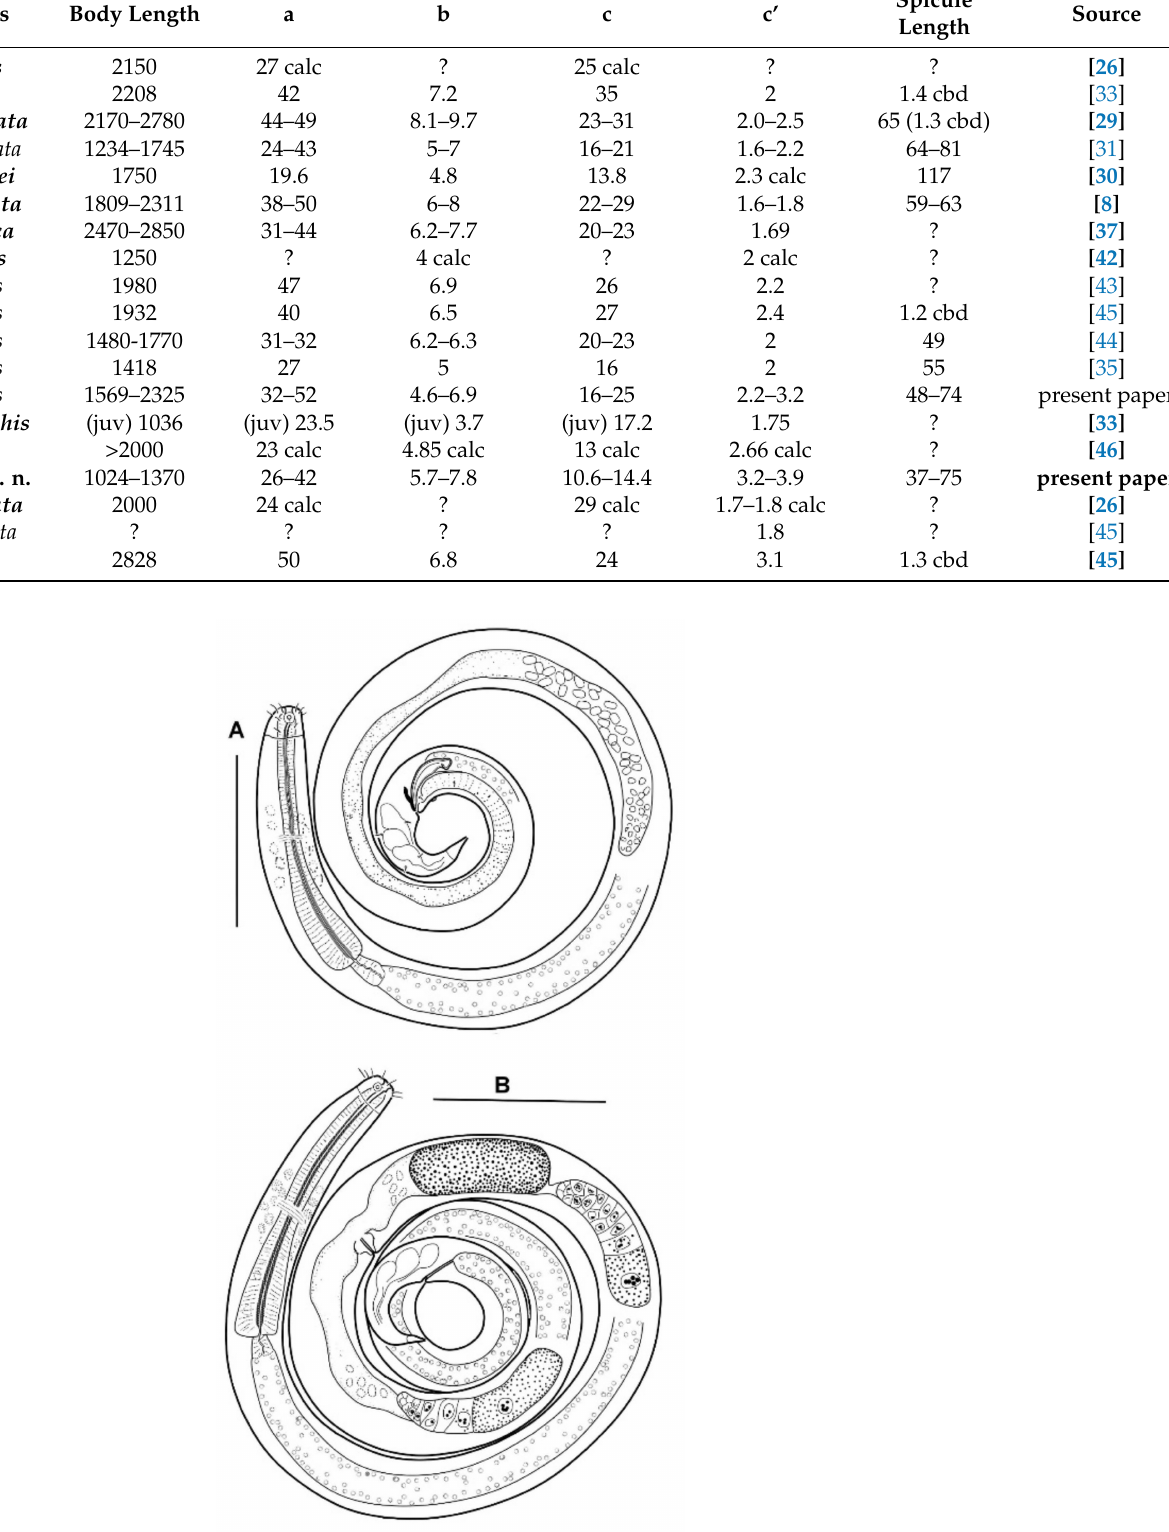
Figure 11. Acanthopharynx parva sp. n., entire: ( A ) holotype male; ( B ) allotype female. Scale bars 100 µ